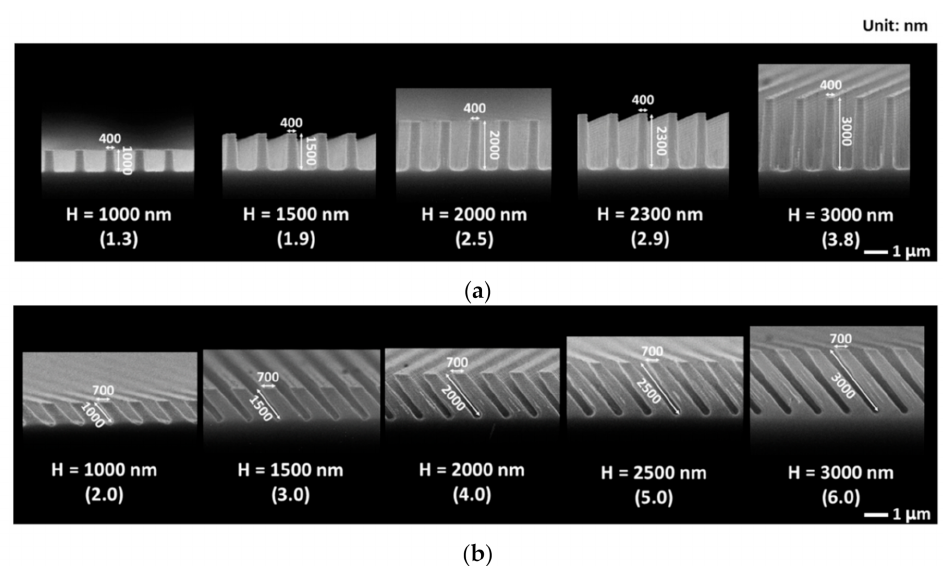
Figure 7. SEM images of Si substrates periodically arrayed with nanopillars at various aspect ratios: ( a ) 0 ◦ ; ( b ) 40 ◦ . The numbers in the parentheses represent the aspect ratios of the trenches between the nanopillars.